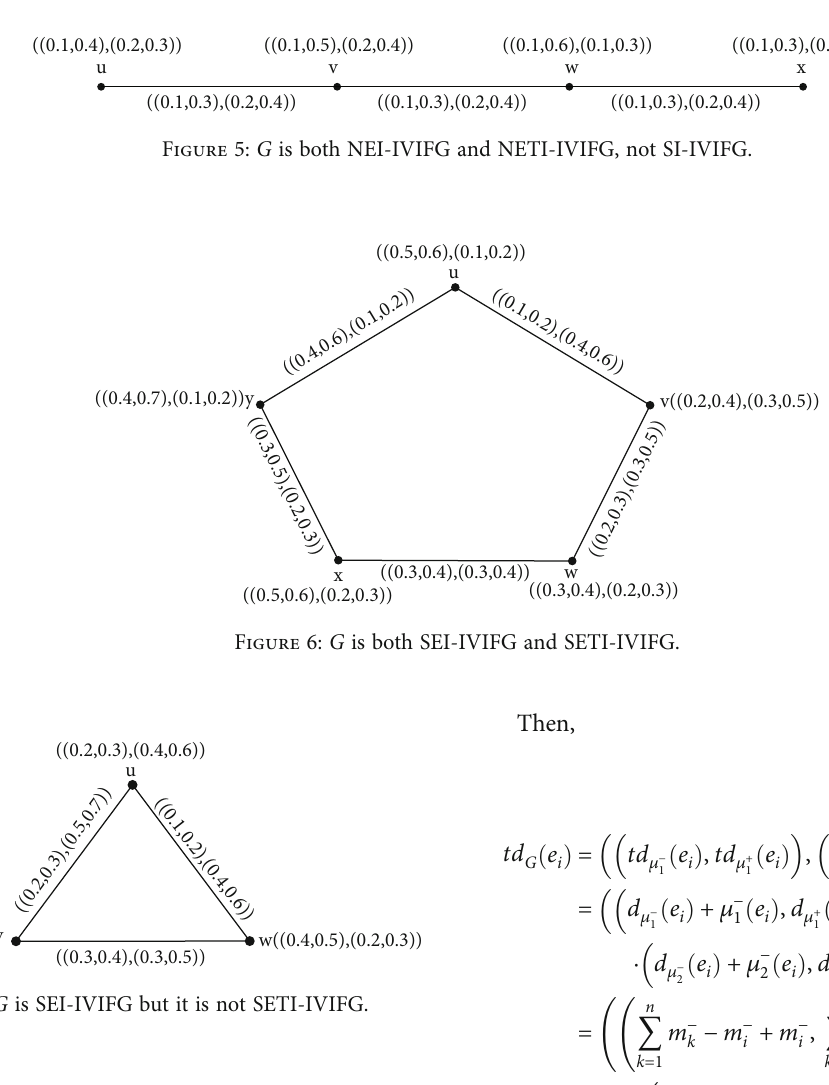
Figure 4: μ is not a CF.